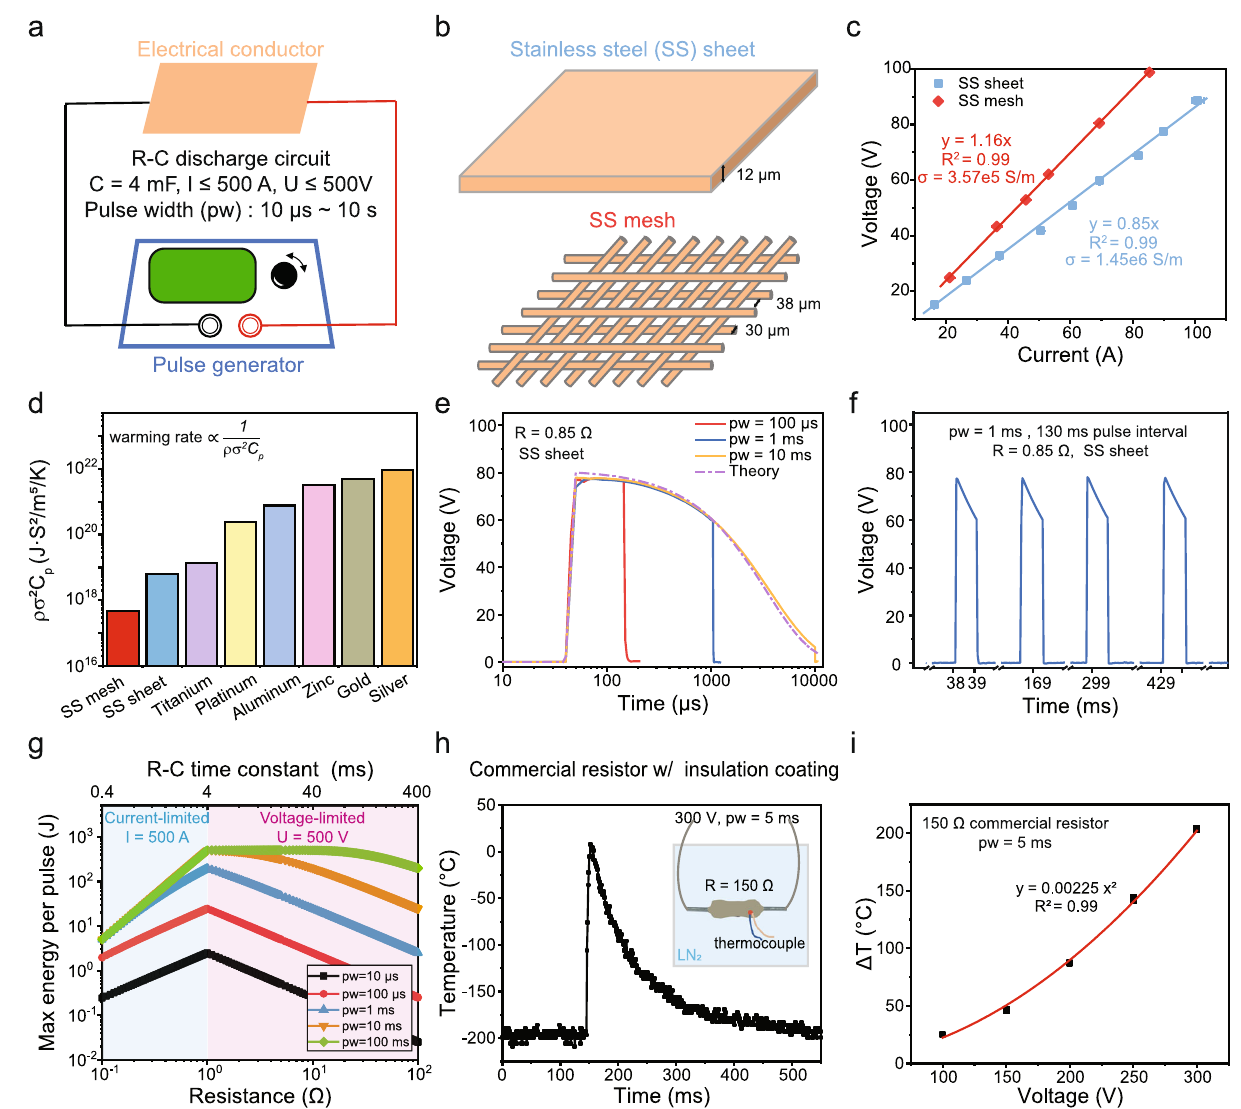
e Voltage pro fi le when different voltage pulse widths were used. The exponential decay ofmeasured voltage matched with the calculated voltageof a R-C discharge circuit. f Voltage pro fi le when multiple voltage pulses were applied. g Maximum energy delivered per pulse depends on the resistance and pulse width. For R ≤ 1 Ω , the max current of 500A is used for calculation. For R ≥ 1 Ω , the max voltage of 500V is used for calculation. h Temperature pro fi le of a thin fi lm resistor (150 Ω ) when subjected to a voltagepulse of300V,5ms. A thermocouplewas attachedto the electrically insulated surface of the resistor. The resistor was submerged in liquid nitrogen (LN 2 ) during the measurement. Sampling resolution was 1ms. i Temperaturechange( Δ T)asafunctionofappliedvoltage.Thesamesetupshown in h was used. n =6 independent experiments. For c and i , data presented as